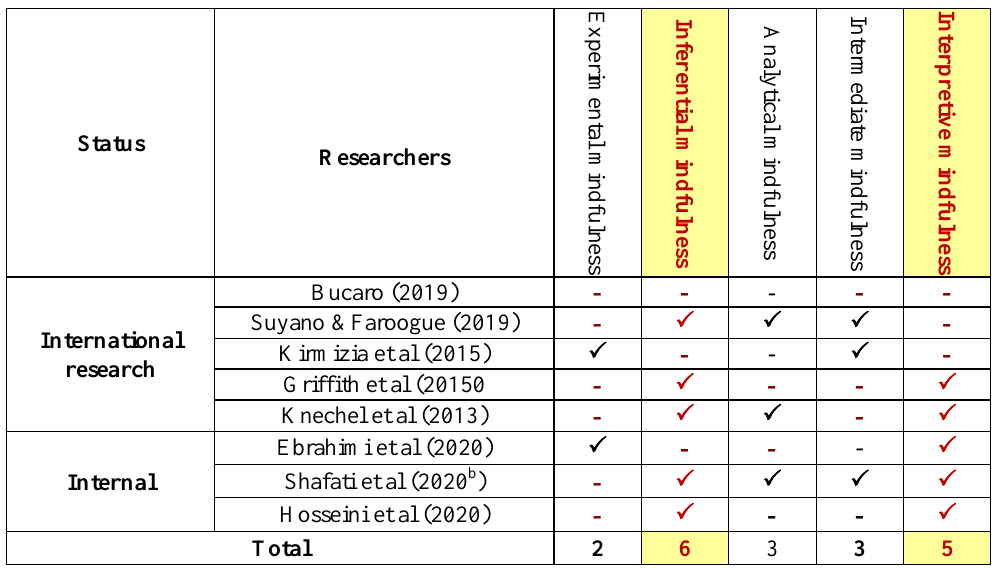
Table 5. the process of determining the main research